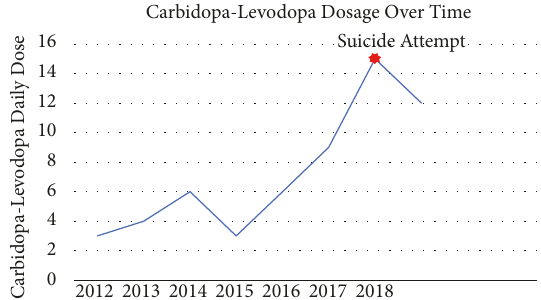
Figure 1: Graph depicting the dosage increase of carbidopa- levodopa over time and the dosage of carbidopa-levodopa at time of suicide